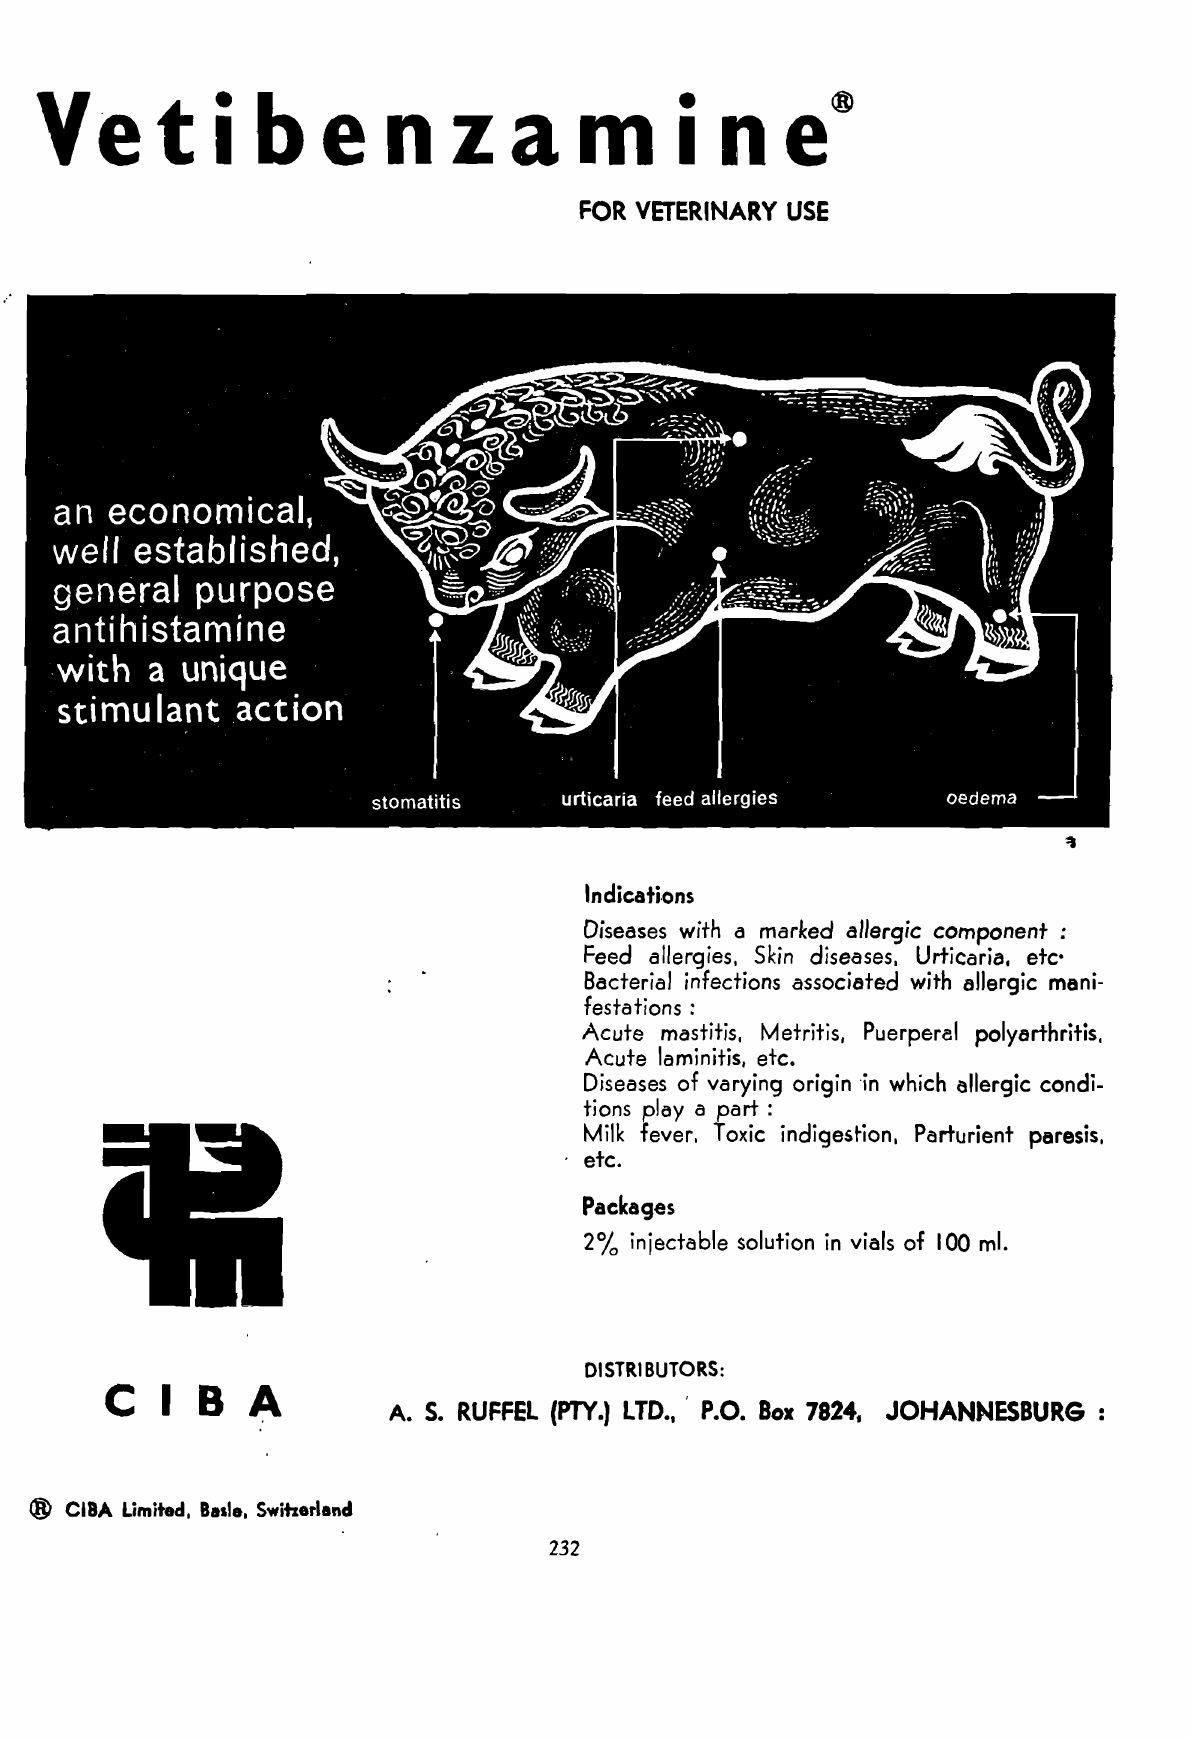
FOR VETERINARY USE